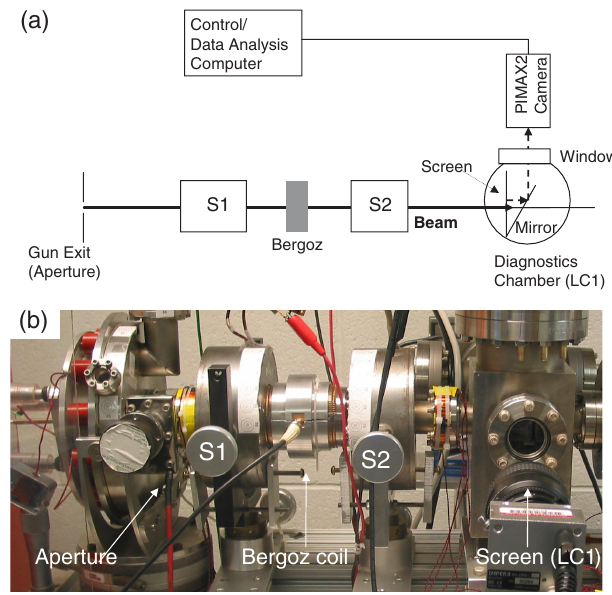
FIG. 1. (Color) Experimental configuration of the LSE: (a) Schematic layout; (b) actual